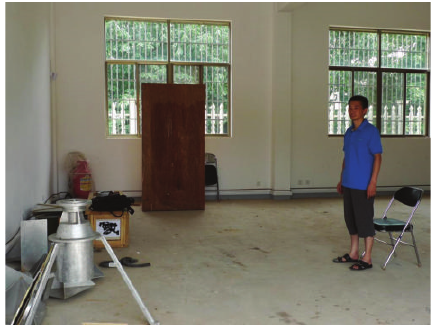
Figure 7: Experimental imaging